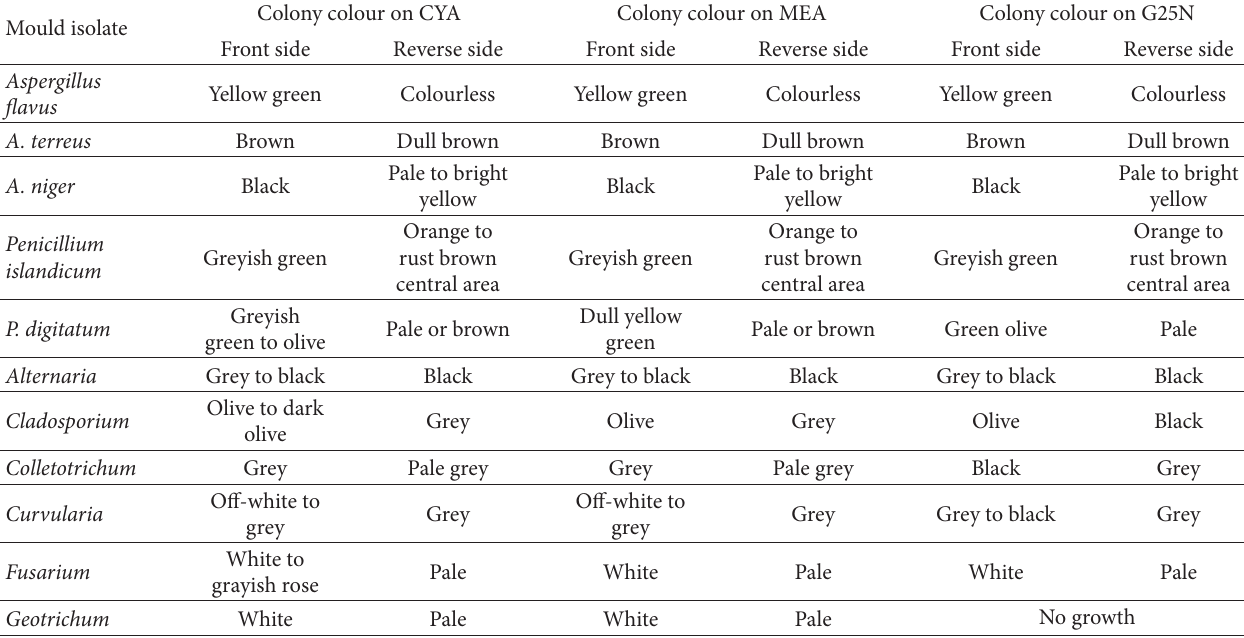
Table 7: Colonial characteristics of different moulds’ isolates of juices on CYA, MEA, and G25N media. Mould